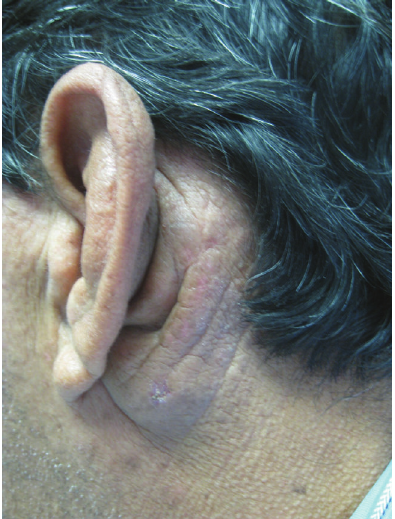
Figure 1: Clinical appearence.